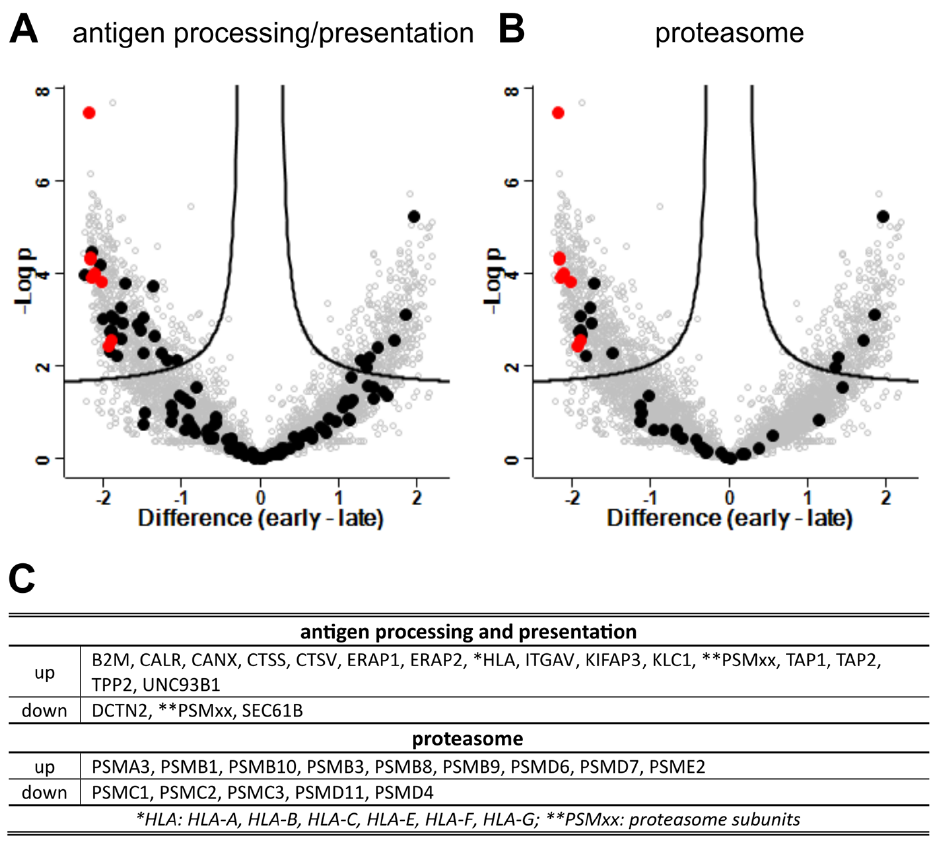
Figure 11. Differentially expressed genes (DEG) in late and early phases of infection: virus proteins, antigen processing and presentation (GO: 0048002), and proteasome (KEGG: 03050). ( A ) Volcano plots highlight genes in black related to the antigen processing and presentation GO term GO:0048002 and ( B ) the KEGG term Proteasome (KEGG:03050). NiV proteins are highlighted in red as a reference for upregulated genes. Black dots represent cellular proteins of the respective pathways. ( C ) Regulated DEG corresponding to GO terms. *: No differentiation of the indicated HLAs was possible. **: proteasomal subunits listed for proteasomes (KEGG: 03050).